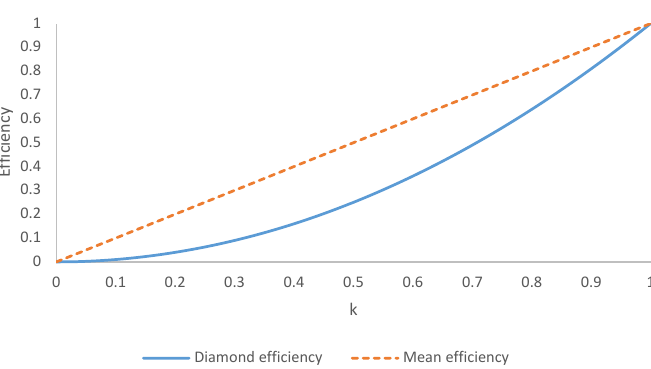
Figure 4. Behavior of the diamond and mean efficiency measures as a function of the perspectives’ efficiency scores when E C = E IP = E I = E F = k .